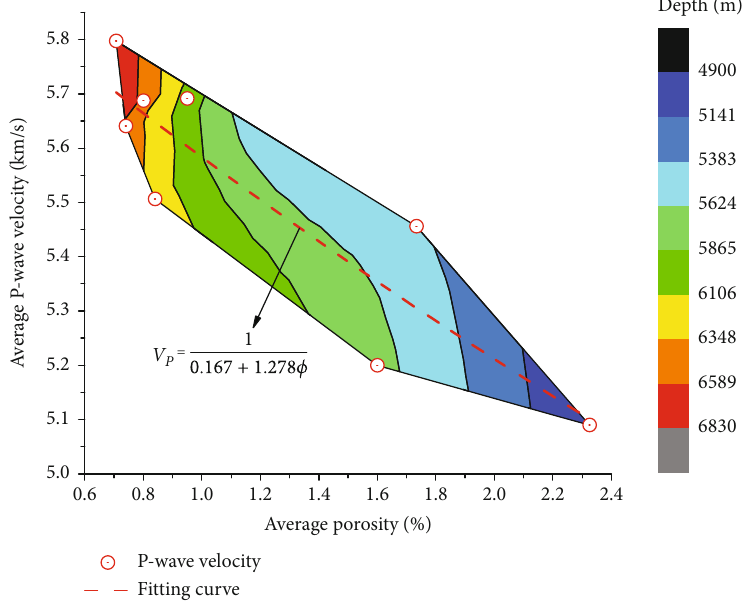
Figure 13: Fitting curve between wave velocity and